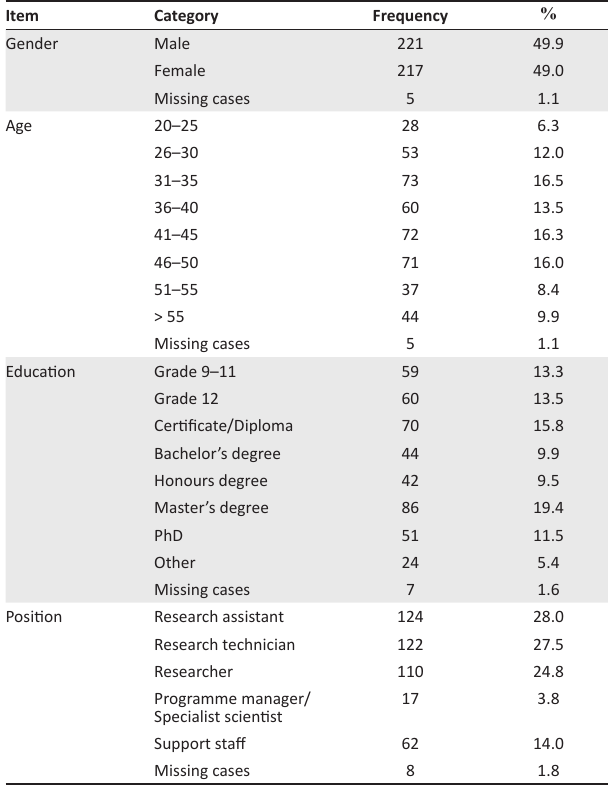
TABLE 1: Biographical information of participants ( N =